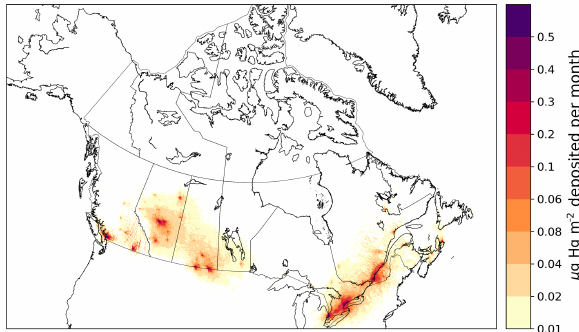
Figure 16. Total atmospheric mercury deposition from anthro- pogenic emissions in Canada during the burning season (May– September) for 2012, given in µgm 2